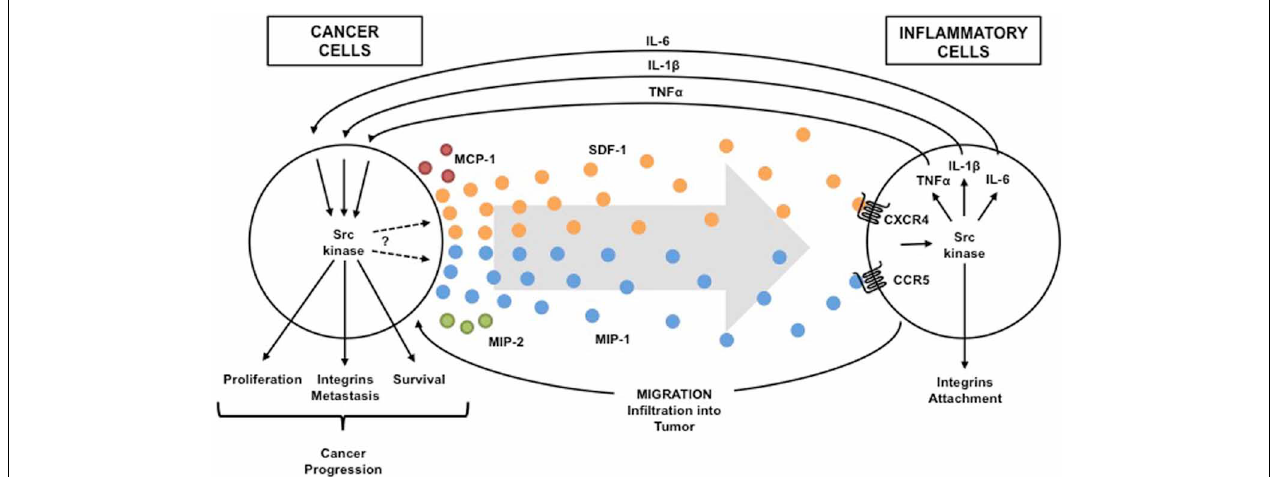
IL-1b, IL-6, etc.) that reciprocally activate Src in cancer cells to promote cancer progression and to induce more cytokine (chemokine) that attract more inflammatory cells into the tumor. Thus, a Src-dependent condition exists in which one problem causes another problem that makes the first problem worse (vicious cycle).